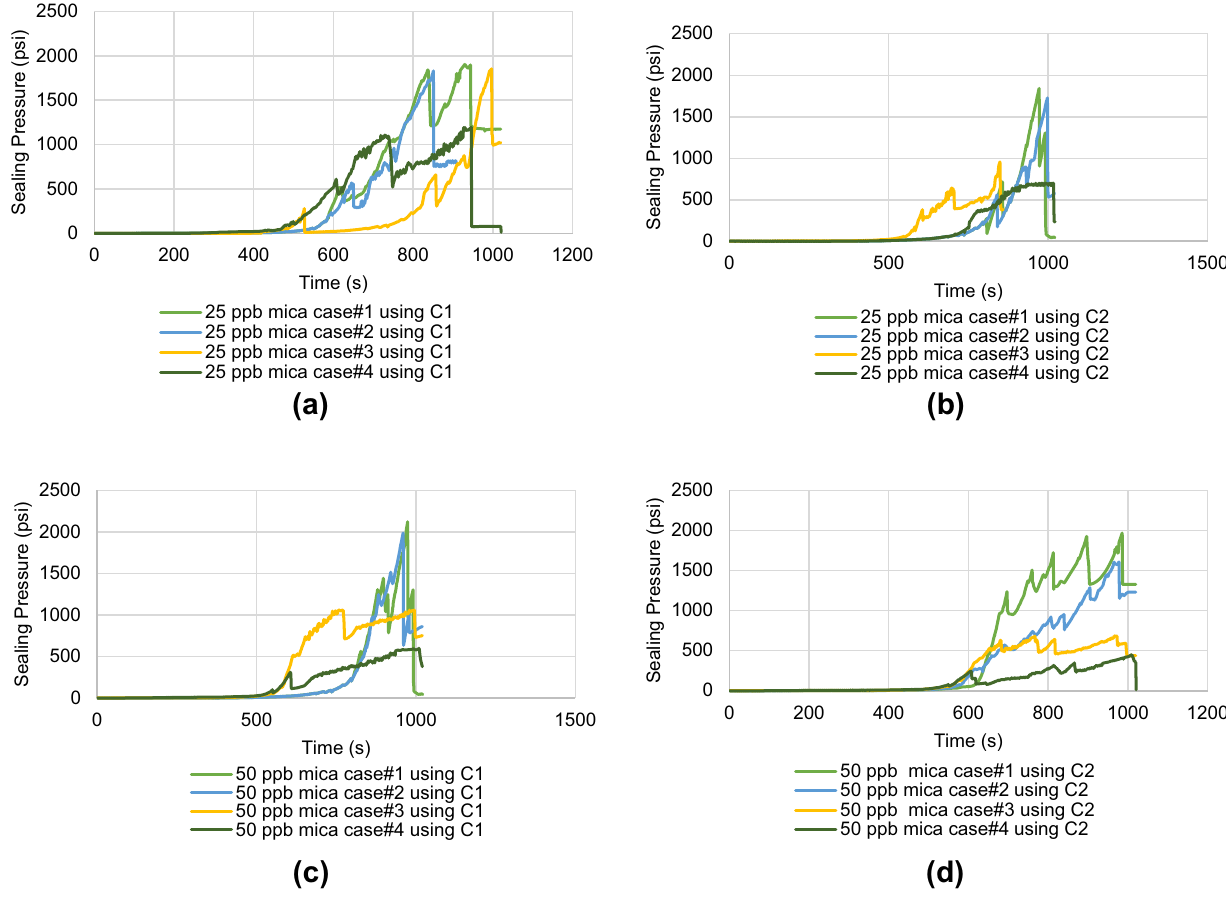
Fig. 14 HPA Pressure versus Time plot for 25 & 50 ppb Mica showing maximum sealing pressure at different cases using C1 and